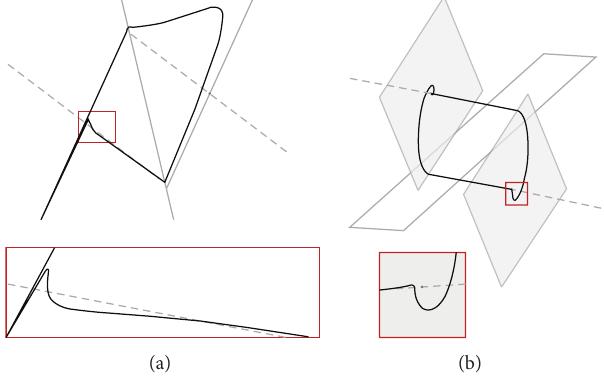
Figure 5: Trajectory close to the homoclinic orbit for dynamical system case 𝐴 (a) and case 𝐵 (b).